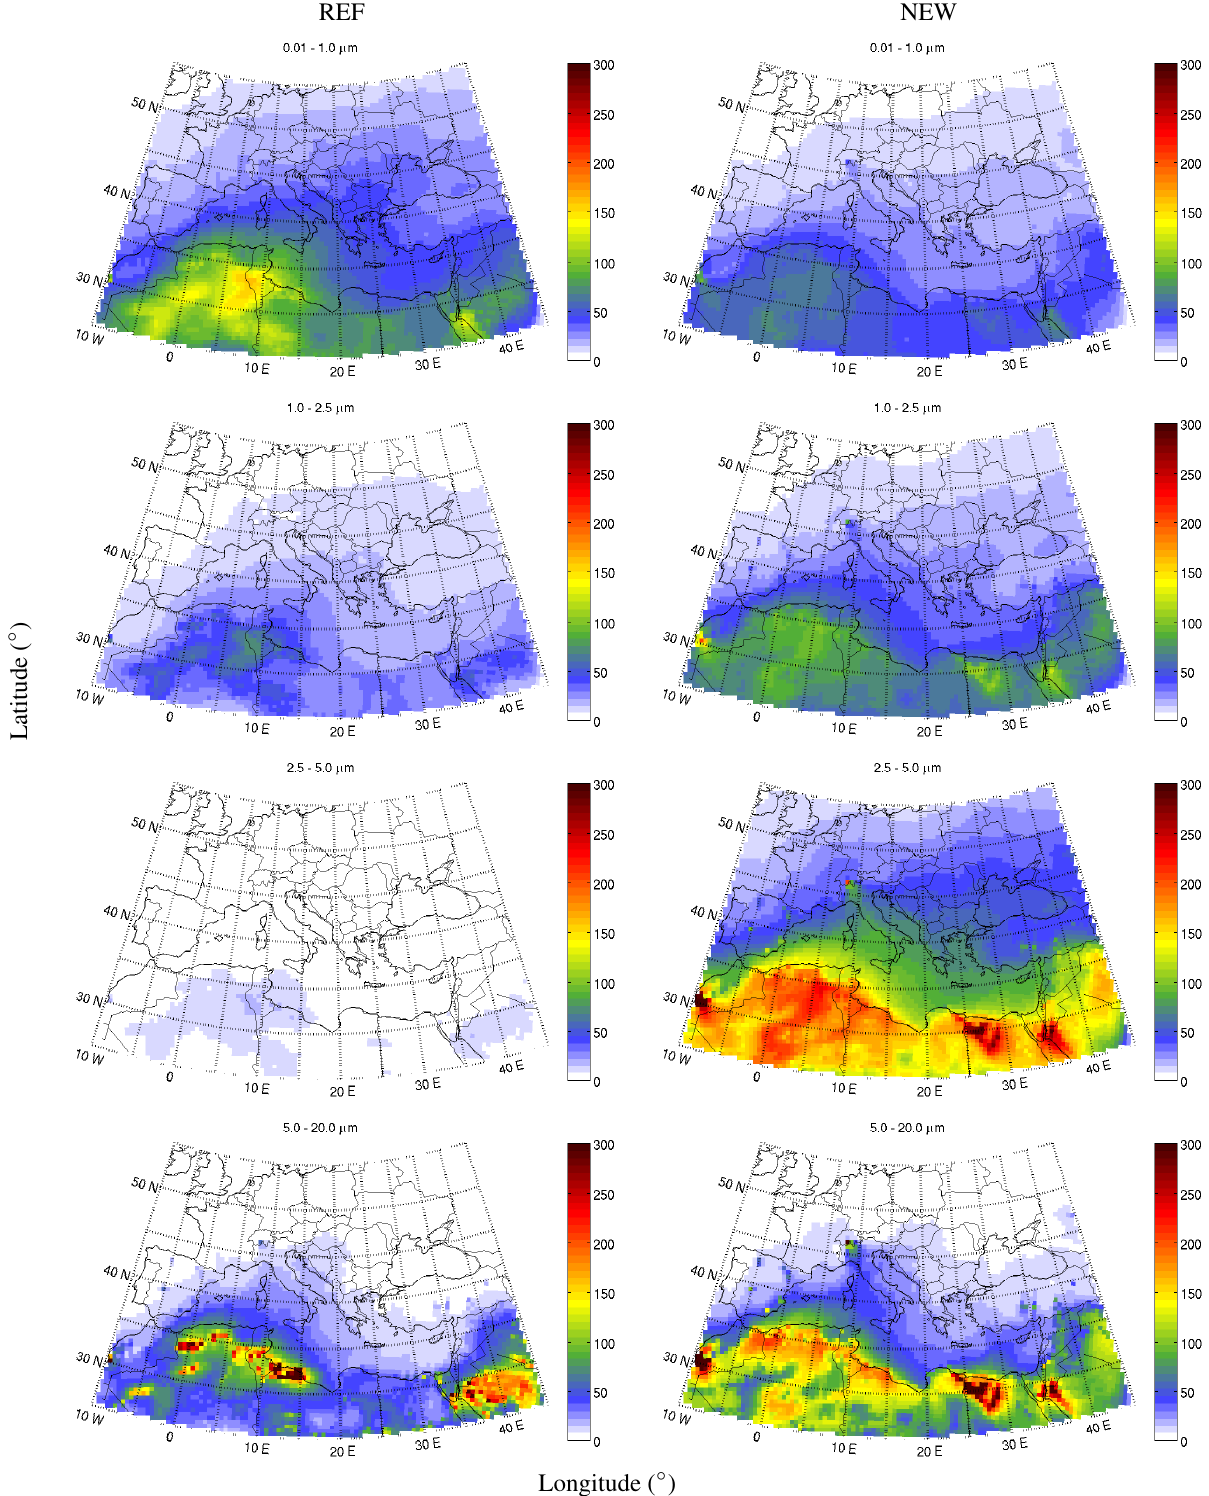
− 2 ) for REF (left panels) and NEW (right panels) experiments over